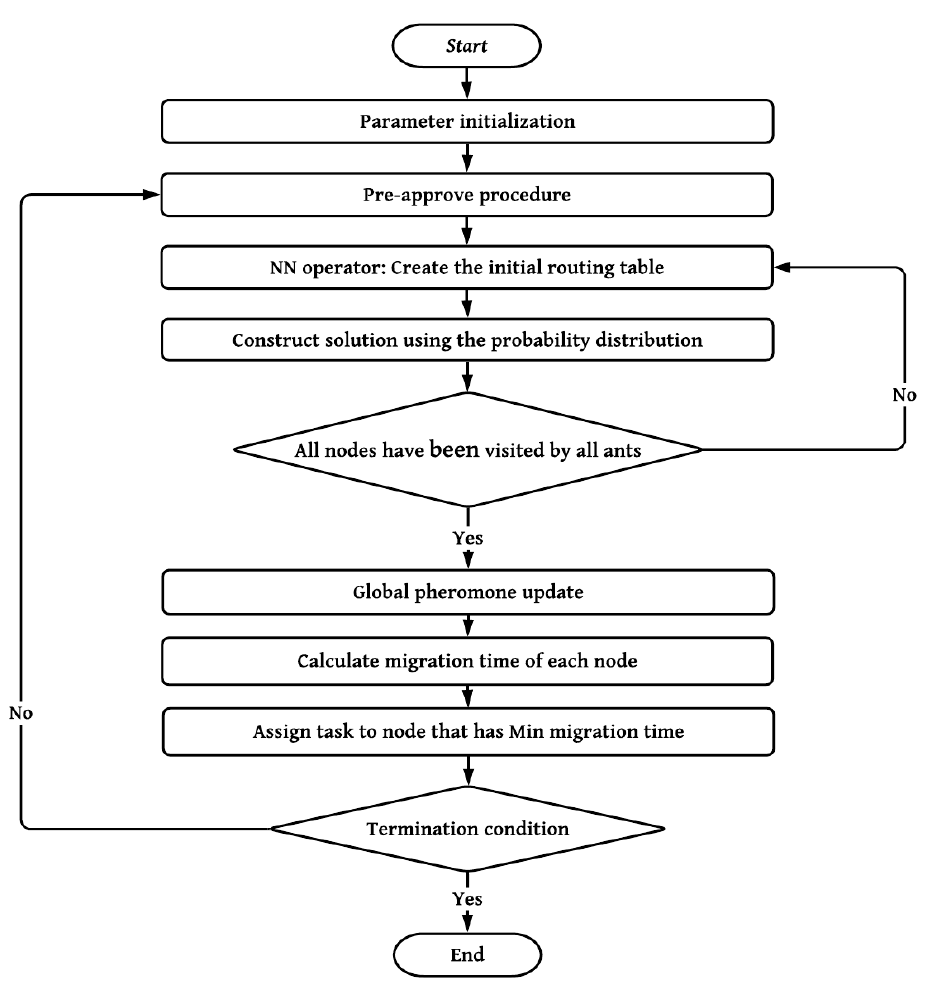
Figure 1. The flow chart of nearest-neighbour ant colony optimization task scheduling